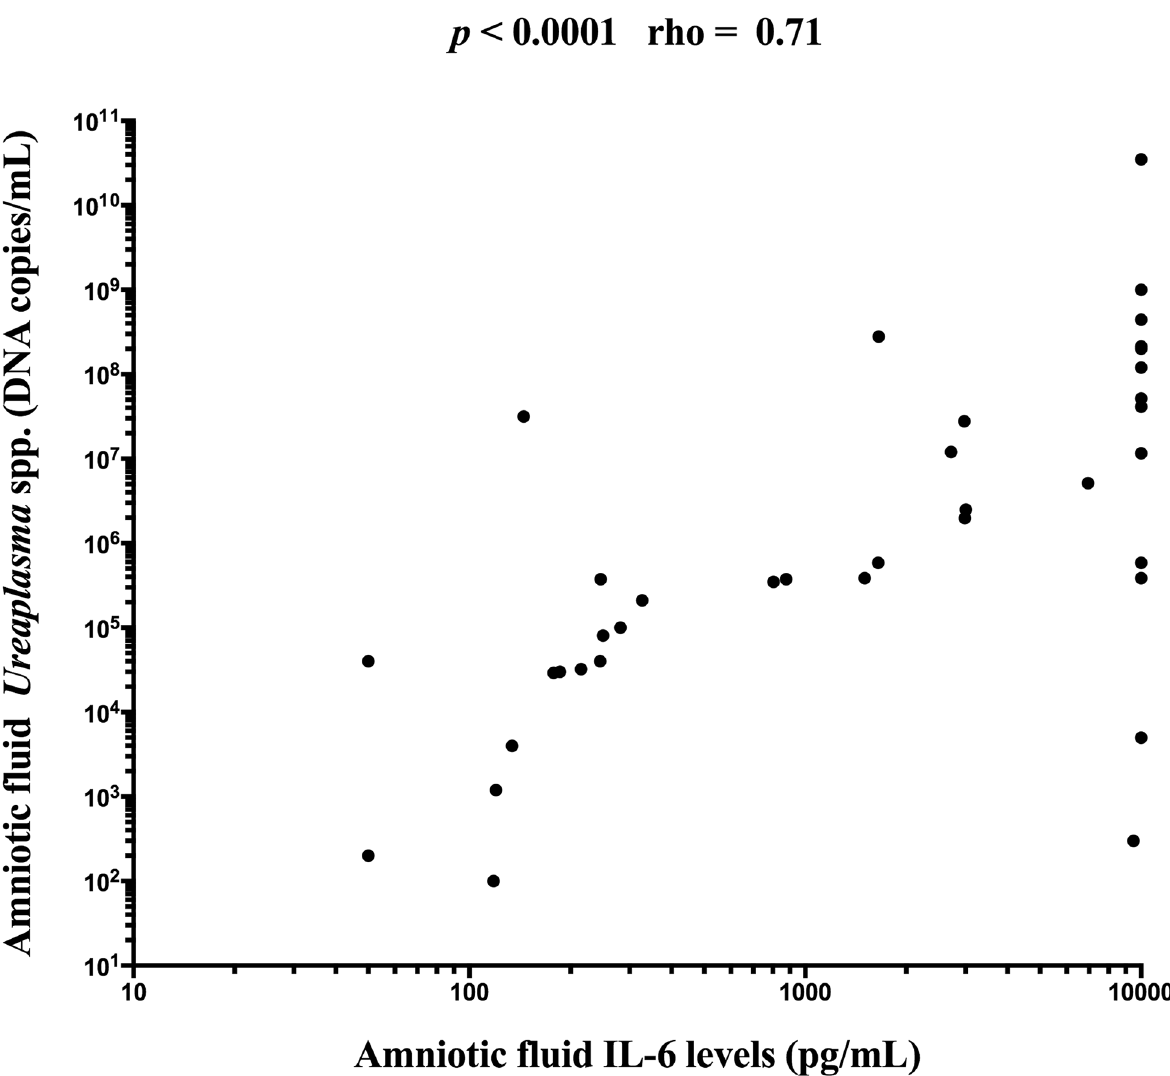
Fig 6. A correlation between microbial load of Ureaplasma species and interleukin-6 in the amniotic fluid from pregnancies complicated by preterm prelabor rupture of